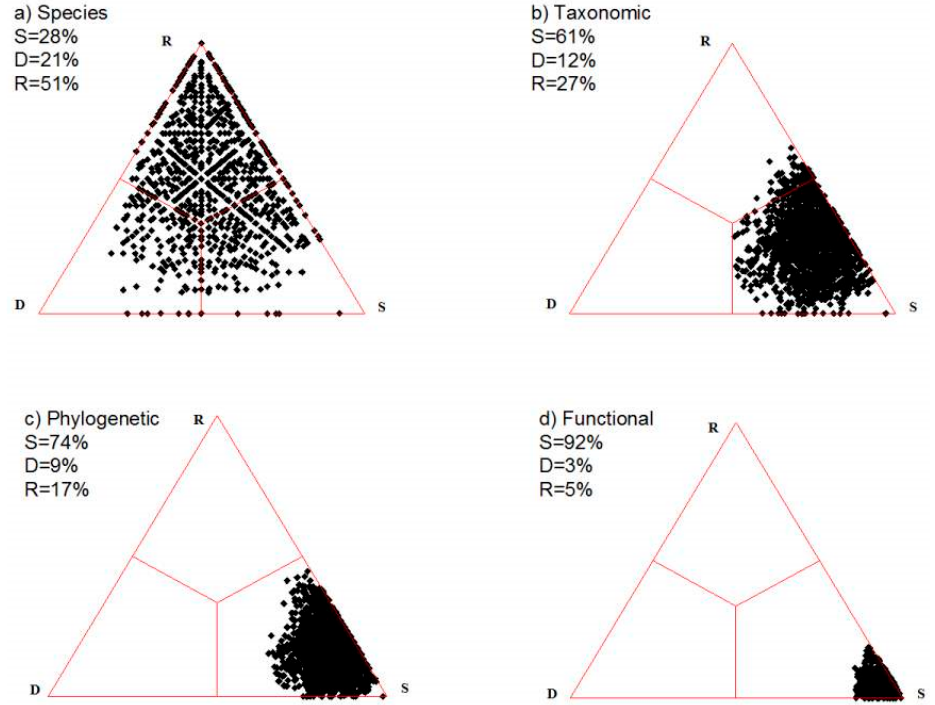
Figure 3. Four simplex diagrams for the primary succession in the alpine zone. Percentage scores refer to the respective centroids multiplied by 100. ( a ) Species; ( b ) Taxonomic; ( c ) Phylogenetic; ( d )